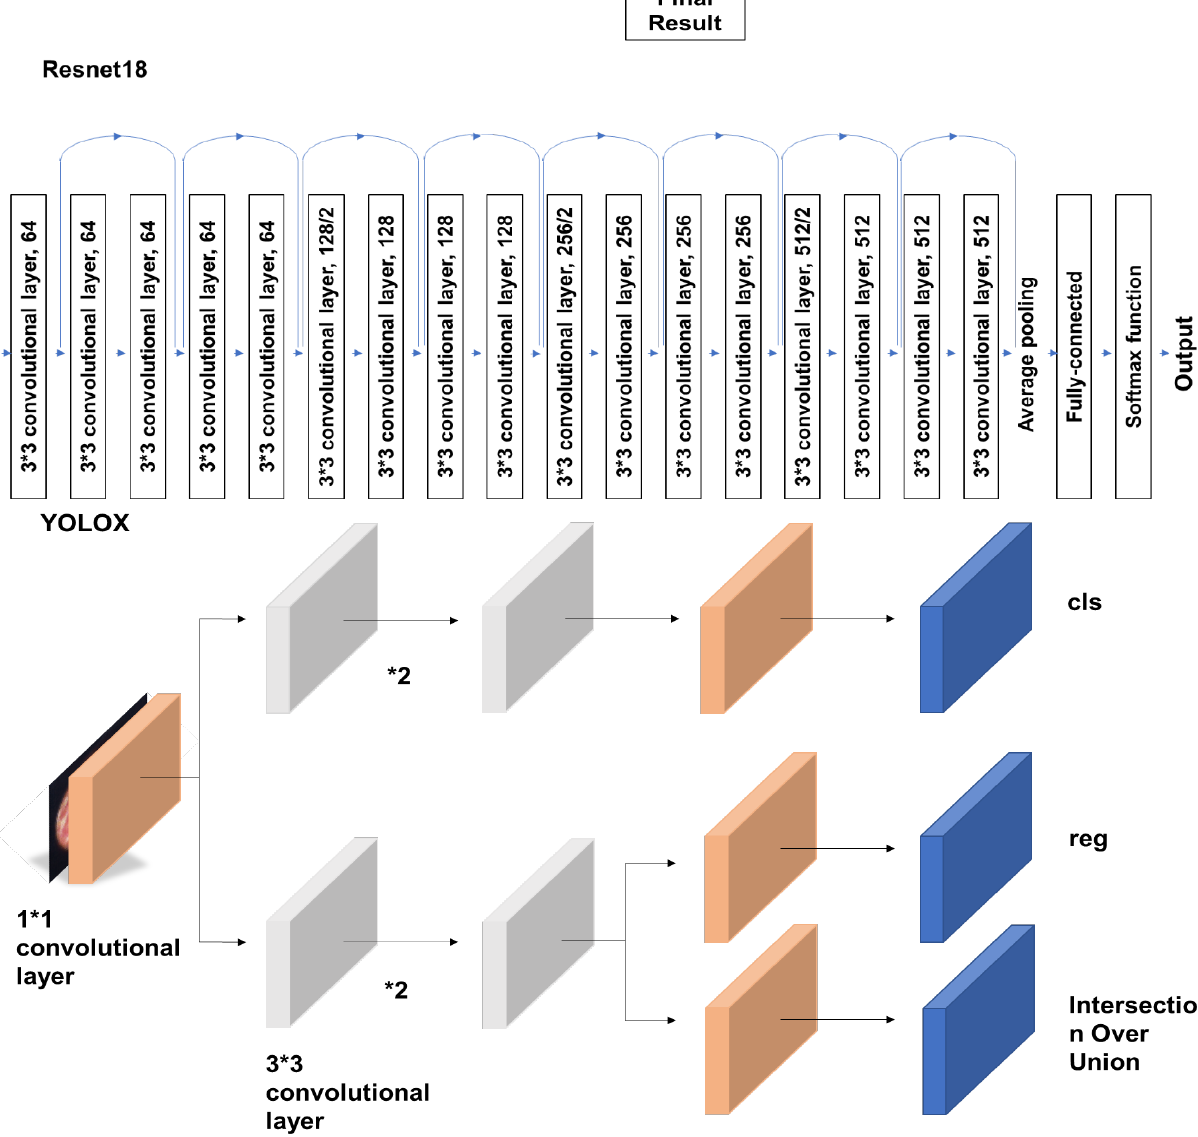
Figure 1. Schema of simplified architectures of XGBoost, Resnet18, and YOLOX.